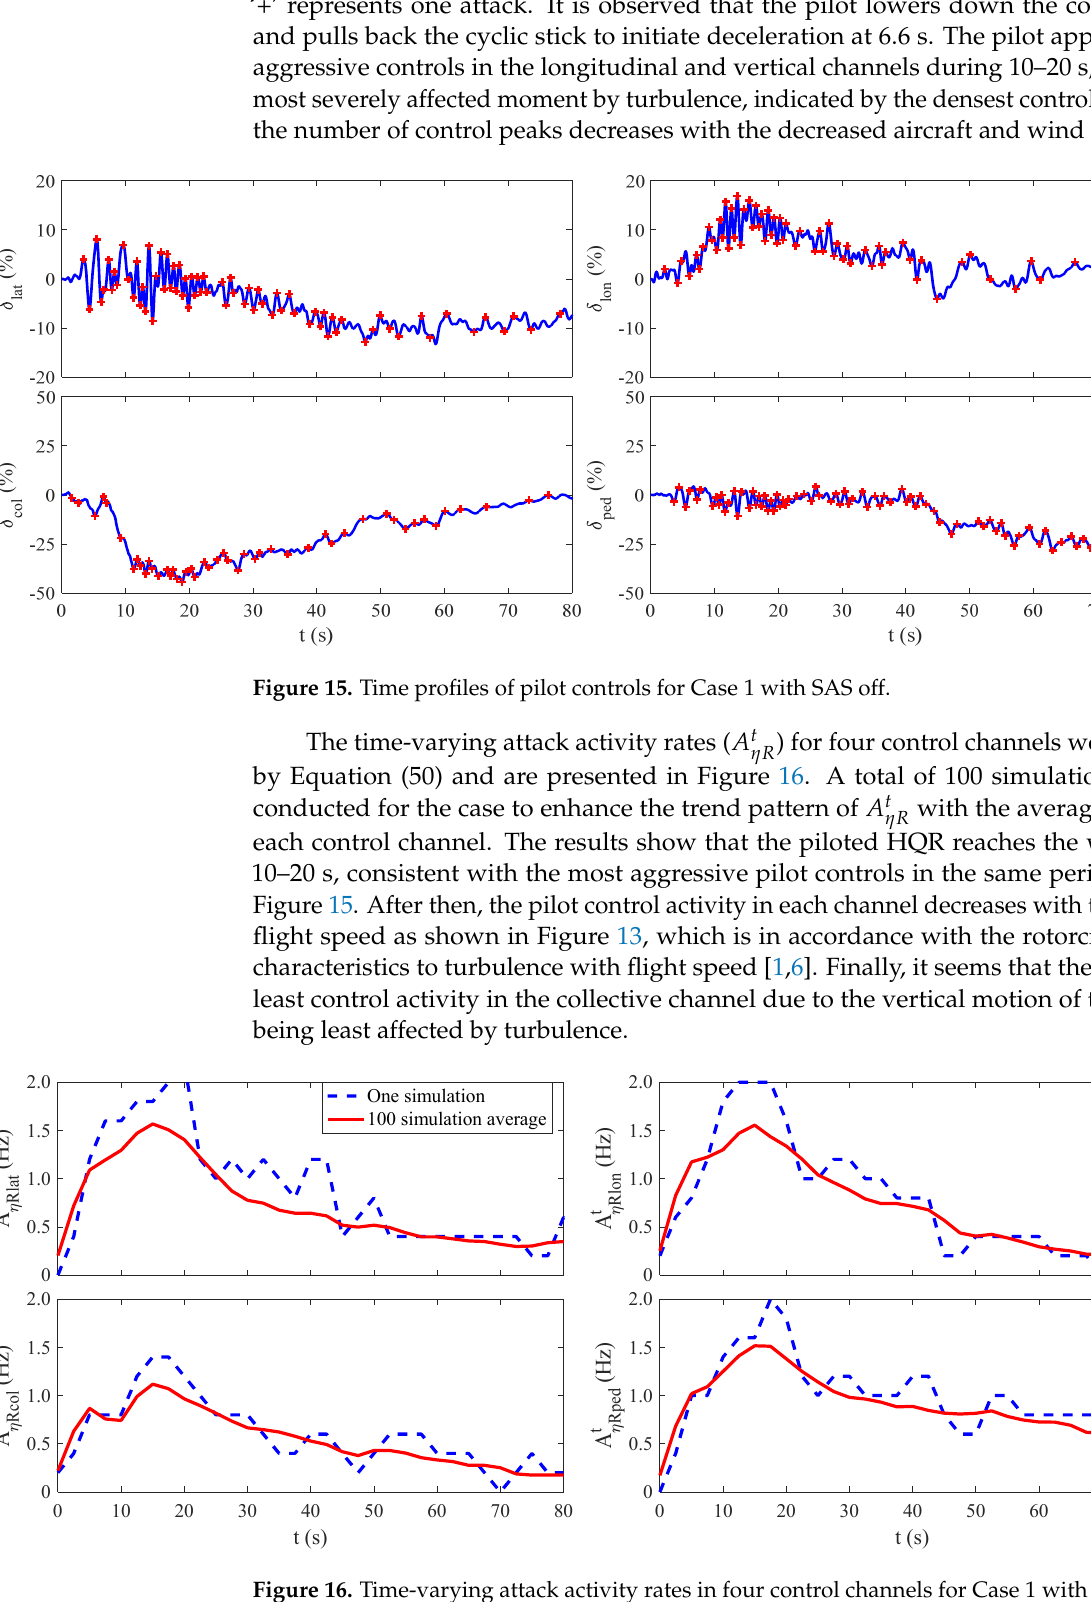
measured by the time-varying combined attack activity rates ( 𝐴 (cid:3086)(cid:3019)(cid:3004)(cid:3047) ). The results are aver- for three wind conditions. However, Case 1 presents the best HQR, Case 2 the worst due to stronger turbulence and larger airspeed resulting from larger wind speed, and Case 3 secondary due to stronger turbulence.